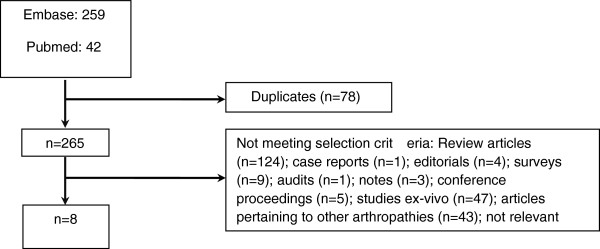
Overview of systematic review of hydroxychloroquine use in osteoarthritis. Databases: PubMed, MEDLINE and Embase. Search terms: MeSH headings #1 ‘osteoarthritis’ and #2 ‘hydroxychloroquine’ or ‘chloroquine’. Limits: Humans.